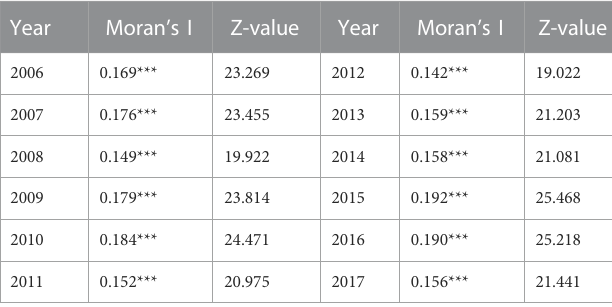
TABLE 2 Calculation of Moran ’ s I index of air